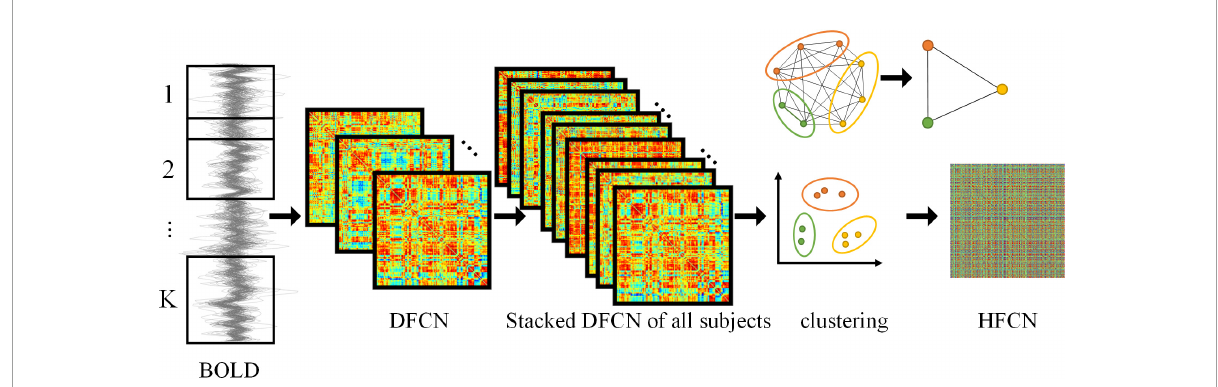
FIGURE1 Framework for construction of DFCN and HFCN. The DFCN is first constructed by computing the PC coefficient under k different sub-windows based on the BOLD signal. Then the DFCNs of all subjects are stacked to extract FC time series and clustered. Finally, the HFCN is obtained by calculating the PC of different FC sequence clusters. The figure in the upper right illustrates the dimension reduction of higher-order networks through